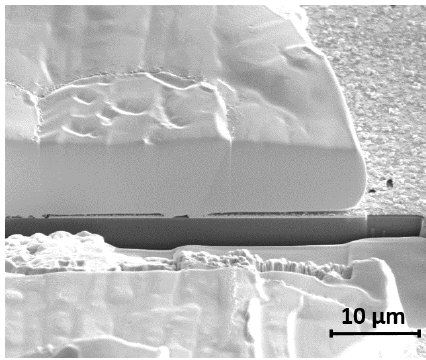
Figure 14. The FIB cut through the centre of a wire bond on thick platinum